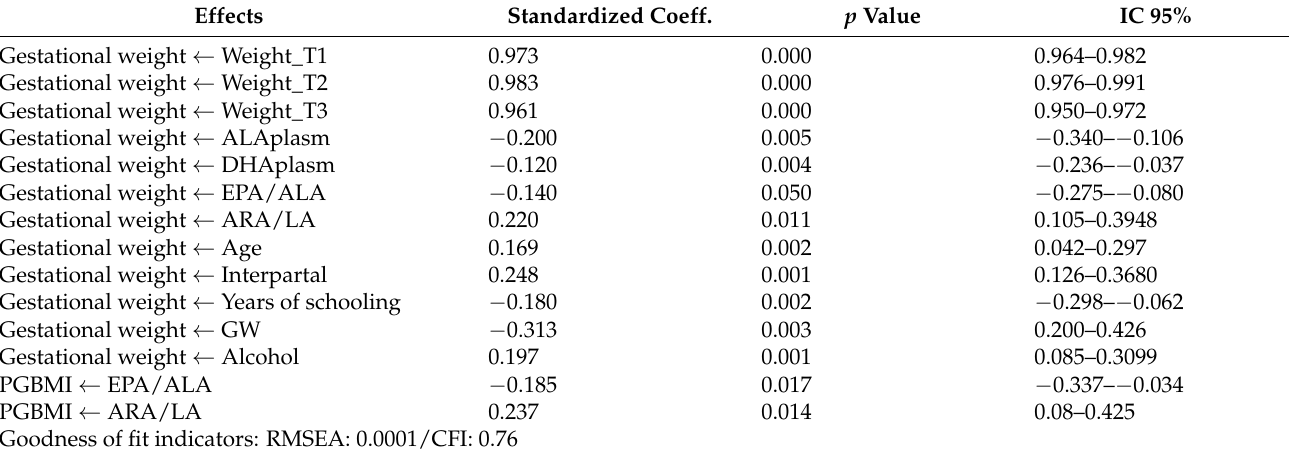
Table 2. Structural equation modeling for the association between plasma levels of polyunsaturated fatty acids and maternal weight throughout pregnancy. Santo Antonio de Jesus, Bahia,